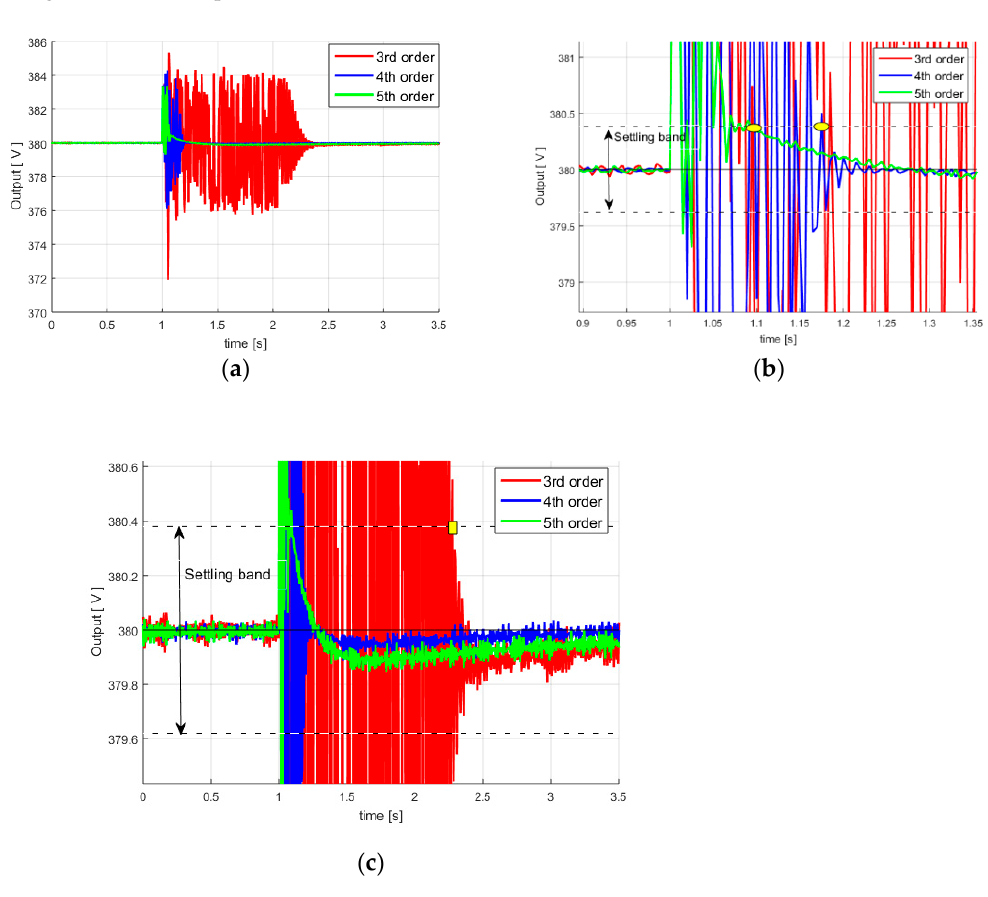
Figure 11. Terminal voltages—resistive load: ( a ) Terminal voltages—overlapped; ( b ) Terminal voltages—zoom 1 ( c ) Terminal voltages—zoom 2.